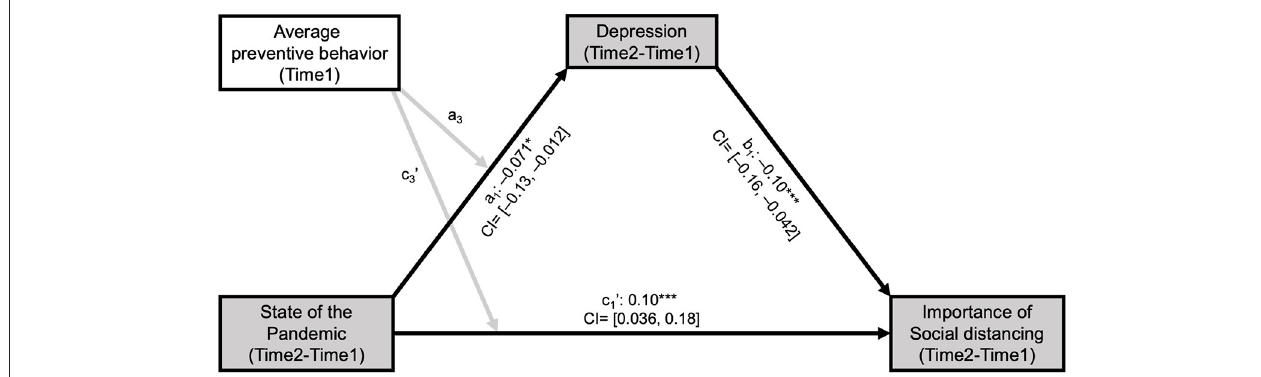
FIGURE 3 | Changes in depressive symptoms mediated the inconsistency between belief about the COVID-19 pandemic state and the perceived importance of social distancing. To examine the moderated mediation effect of depressive symptoms, we set belief about the COVID-19 pandemic state (negative score for Time 2—Time 1 indicates “pandemic got worse”) as a predictor, the average tendency of individuals to follow preventive behaviors (e.g., wearing masks) as a moderator and perceived importance of social distancing as an outcome variable. Change in depressive symptoms between Times 1 and 2 was significantly associated with a change in belief about the COVID-19 pandemic state negatively (a 1 : t = − 2.40, P = 0.016) and with an average tendency to follow preventive behavior before Time 1 positively (a 2 : t = 2.39, P = 0.017; path not depicted). An increase in the severity of depressive symptoms was associated with a decrease in the perceived importance of social distancing (b 1 : t = − 3.39, P = 0.00072). After adjusting for the mediation effect of change in depressive symptoms, the direct effects of belief change (c 1 ’: t = 3.56, P = 0.00038) and average tendency to follow preventive behavior (c 2 ’: t = − 1.99, P = 0.047; path not depicted) on the perceived importance of social distancing was still significant. Moderated mediation effects of the two predictors (i.e., the interaction between the state of the pandemic and average preventive behavior) on change in depressive symptoms (a 3 : t = − 0.87, P = 0.93) and change in the perceived importance of social distancing (c 3 ’: t = − 1.73, P = 0.083) were not significant. Black and gray arrows indicate significant and non-significant associations between the components, respectively. * P < 0.05, *** P < 0.001; CI: 95% bootstrap confidence interval for each of the standardized beta